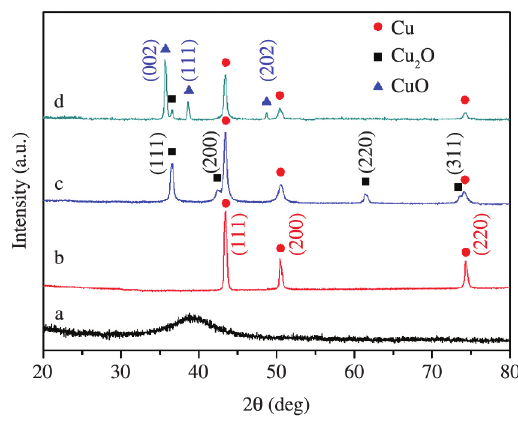
Figure 2. XRD patterns of the Cu in 1.2 M HCl solution at 298 K for (a) 0 h, (b) 12 h, (c) 14 h, (d) 18